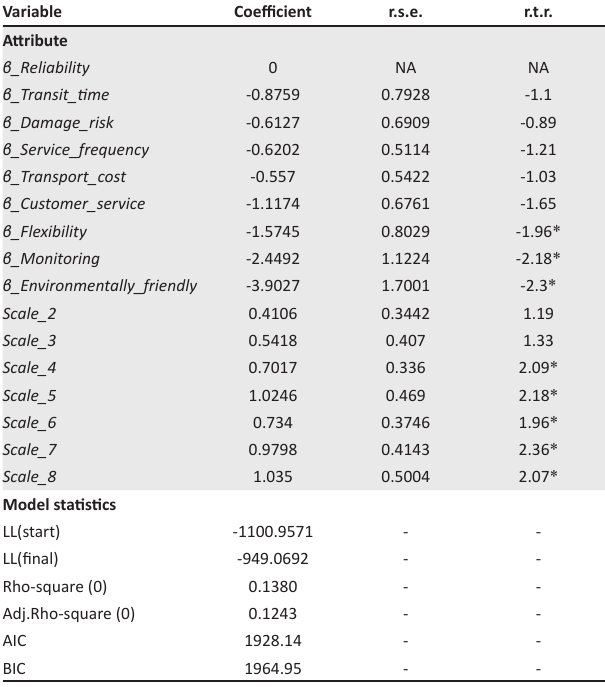
TABLE 3: Ranking of attributes: Results of the exploded logit model.